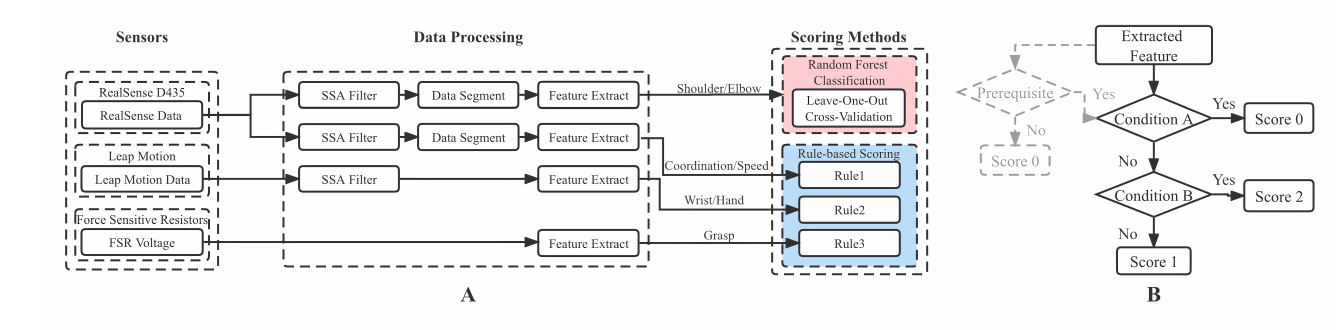
Figure 3. ( A ) Flow chart of data analysis. SSA: singular spectrum analysis. ( B ) The general IF-ELSEIF- ELSE logic model of scoring rules, where the gray part indicates that several items require